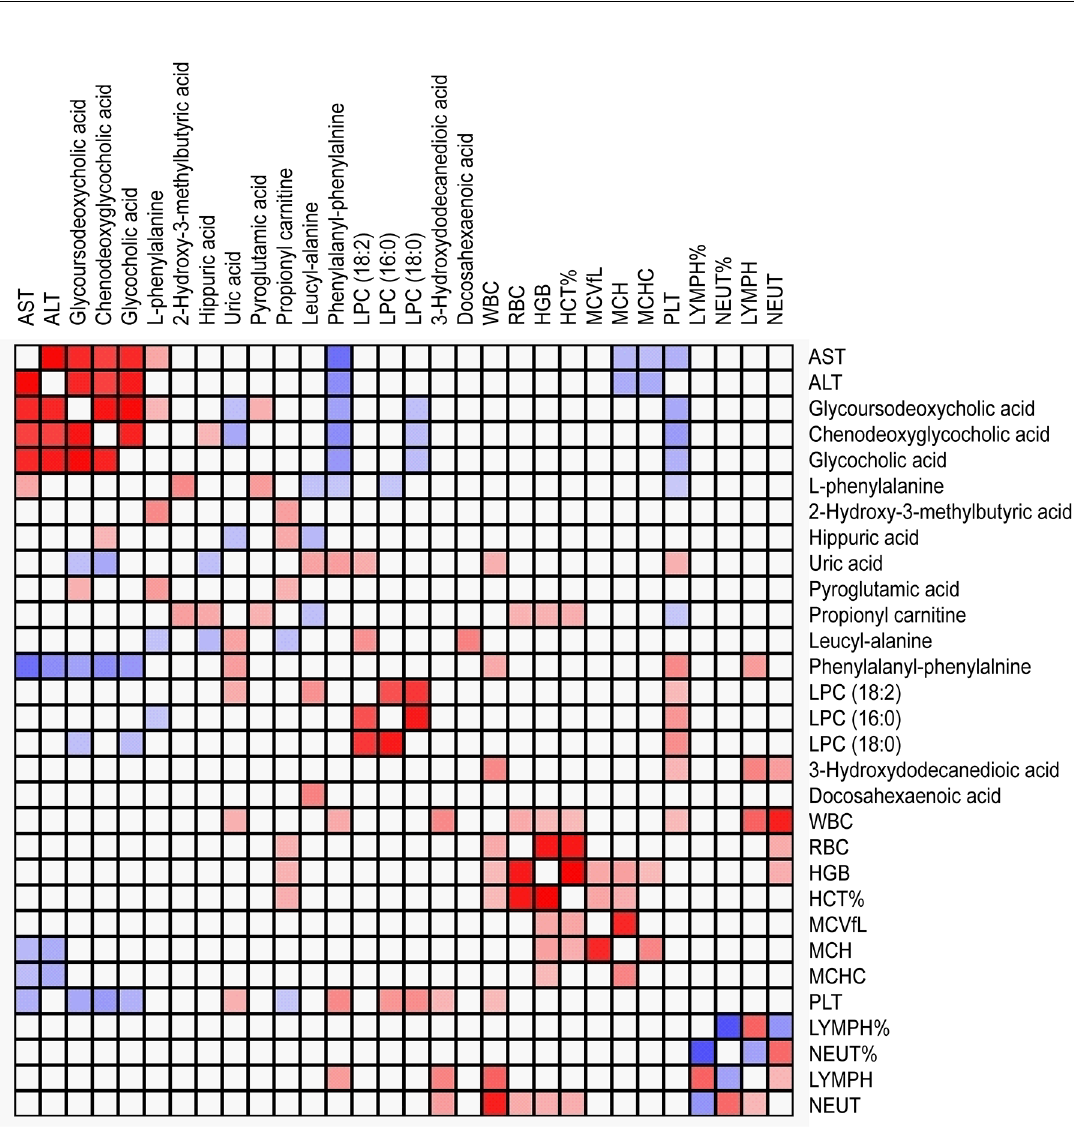
Fig 3. Pearson correlation analysis reveals correlation of bile acids with aspartate transaminase (AST) and alanine transaminase (ALT) levels in the critical phase of infection.